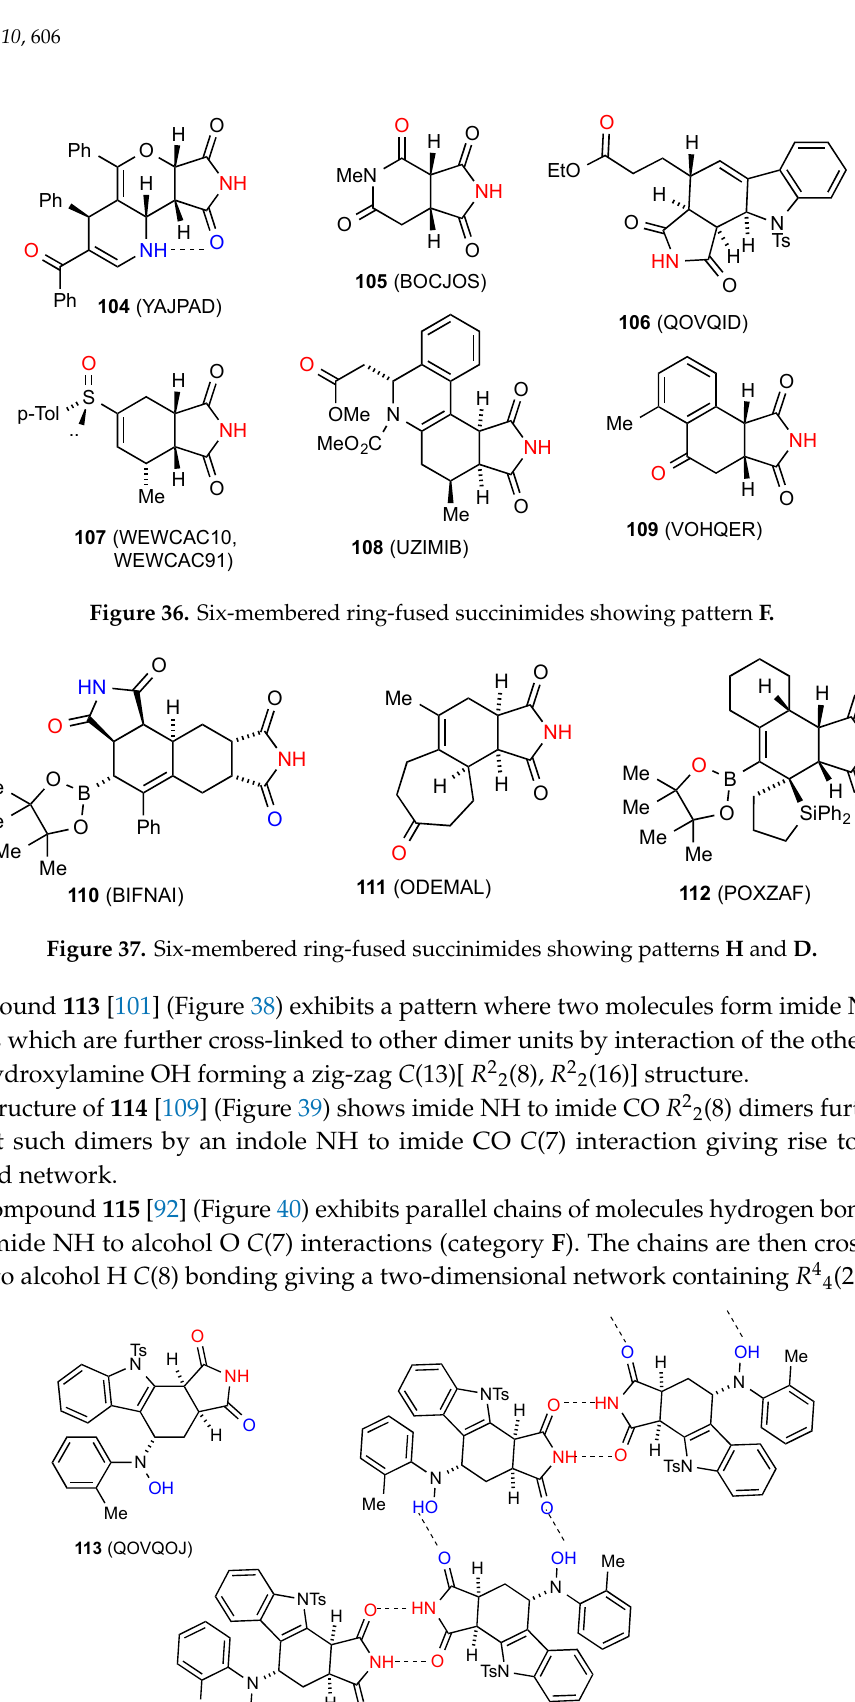
Figure 38. Structure adopted by compound 113.